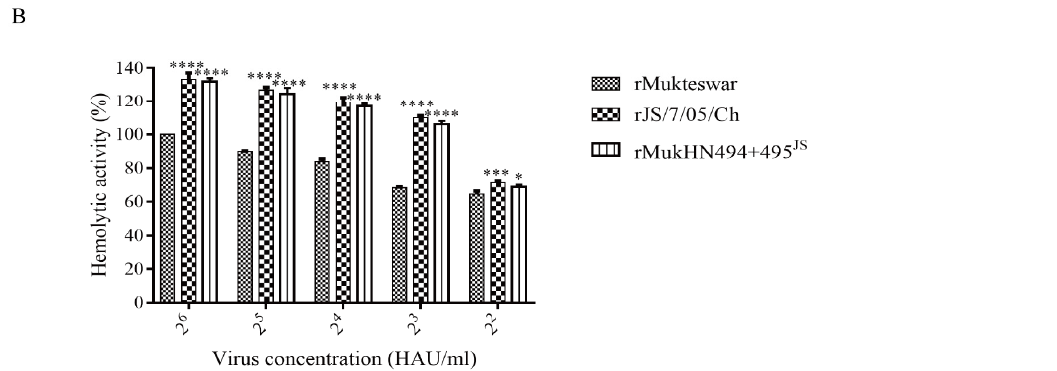
Figure 5. Syncytium formation and hemolytic activities of NDVs bearing different HN proteins. ( A ) Vero cells were infected with three viruses at 0.1 MOI for 24 h, and then detected for the syncytia formation. Images were taken under a microscope at × 200 magnification. White arrows were used to mark the syncytia formation. Bar indicates 200 µ m. ( B ) The hemolytic activity was compared among the parental and recombinant viruses. Statistical significance was compared with that of rMukteswar. All values are normalized to the expression of the values for rMukteswar, which was set at 100%. * p < 0.05, *** p < 0.001, and **** p < 0.0001.